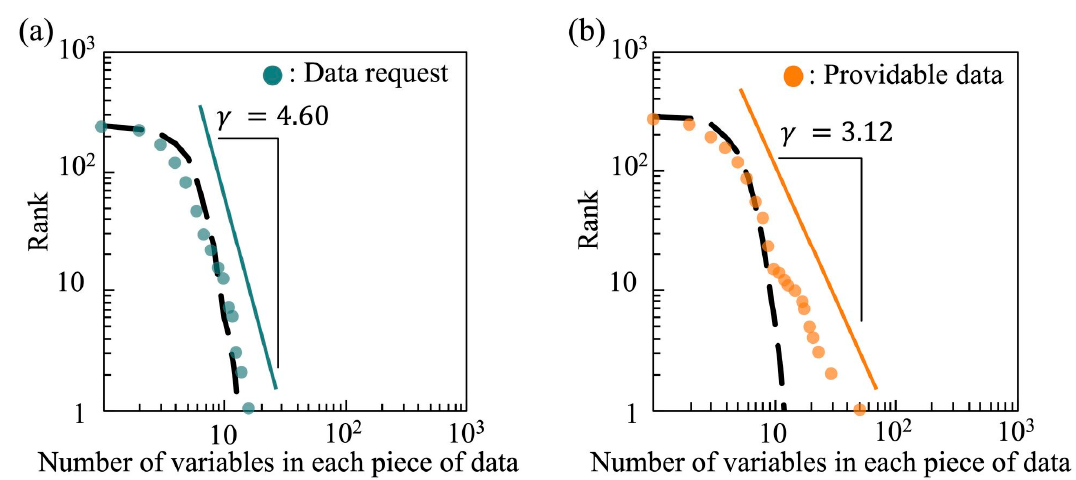
Figure 4. Distributions of the number of variables in each piece of data for ( a ) data requests and ( b ) providable